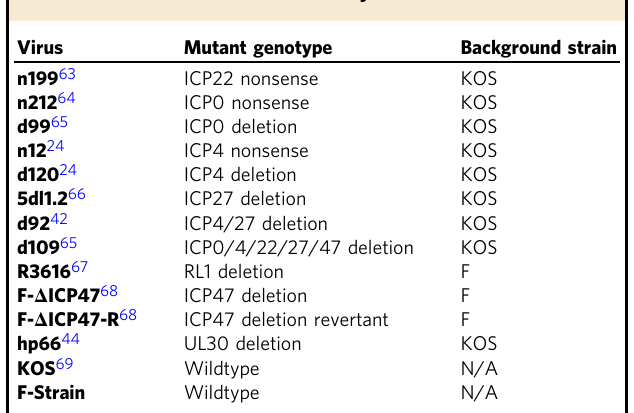
Table 1 HSV-1 viruses used in